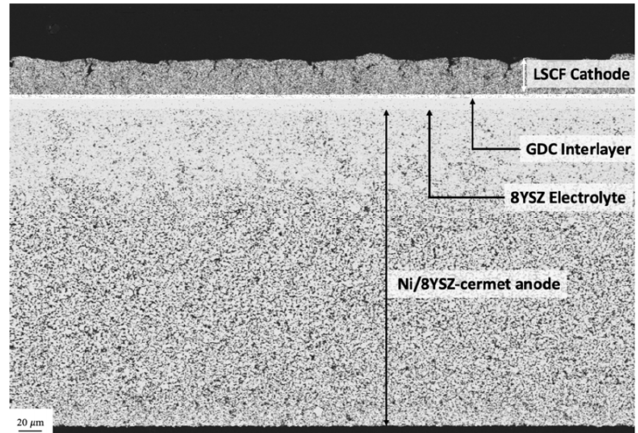
Figure 7. SEM backscattered electron image of cell cross-section.